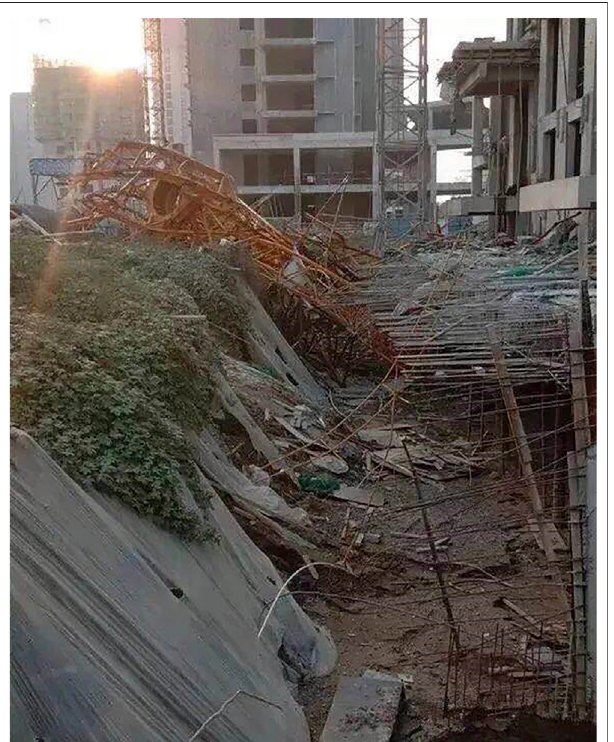
FIGURE 1 | Accident of tower crane during installation.